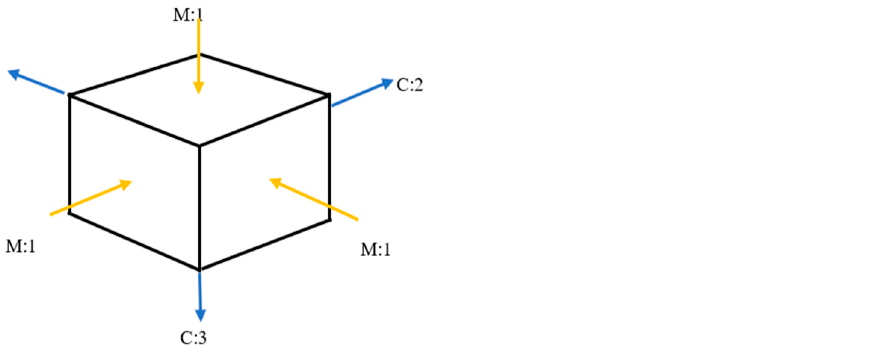
Figure 15. Spectral functions of the FRF transition for the ordinary concrete cube with the 20% ad- dition of fly ash from the sewage sludge ash addition. Legend: spectral transition function FRF (Side A), spectral transition function FRF (Side B), spectral transition function FRF (page C). The initial analysis of the obtained spectra focuses on the case of the cube without the addition of ash around the three natural frequencies marked in Figure 15. The situa- tion is completely different in the case of the spectral transition functions determined for the cube with the 20% ash addition. In addition to much more convergent spectra, three characteristic vibration frequencies were also obtained. A particularly interesting situa- tion is that in the predetermined natural frequencies, there is a very large discrepancy between the cube with and without the additive. This would initially indicate a significant differentiation of these two building materials in terms of their dynamic properties. Ad- ditionally, the analysis of individual phase shifts indicates the occurrence of the structural vibrations of at least one of the three predetermined natural frequencies for the cube with- out the addition of ash. Figure 16 shows the spectral transition function of the FRF in the amplitude form for a cube without the addition of ash with a marked natural frequency of 2831.86 [Hz]. It should be clearly emphasized that the determined natural frequency occurs simultane-